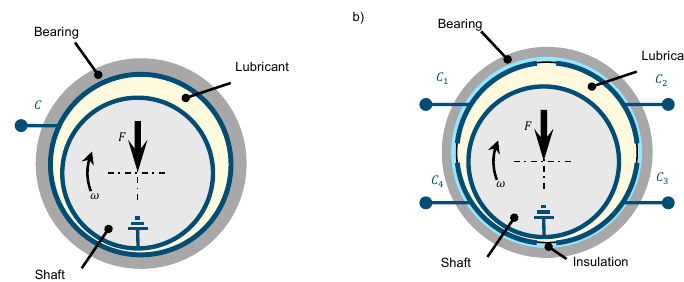
Figure 5. ( a ) Hydrodynamic journal bearing with contacted bearing modeled as a cylindrical capacitor; ( b ) hydrodynamic journal bearing with four capacitors separated by an insulation (cf. [51]).